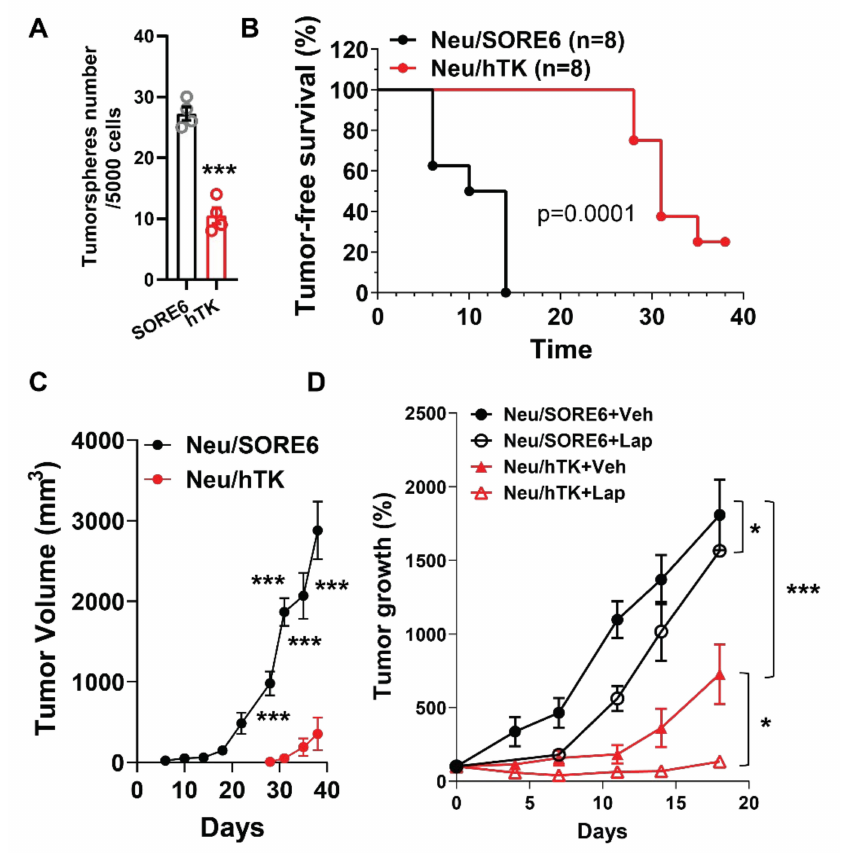
Figure 6. Ablation of SORE6 + CSCs suppresses Neu tumor initiation and progression and enhances the therapeutic efficacy of lapatinib. ( A ) GVC (10 µ M) treatment suppresses tumorsphere formation of Neu cells expressing SORE6-hTK (hTK) as compared to SORE6-mCherry (SORE6). *** p < 0.001 vs. SORE6, n = 4. ( B – D ) Neu cells expressing SORE6-mCherry (Neu/SORE6) or SORE6-hTK (Neu/hTK) were implanted into the mammary fat pad of nude mice and were either treated with GCV (25 mg/kg, i.p., daily) for 21 days immediately following implantation ( B , C ) or with GCV (25 mg/kg, i.p., daily) in combination with vehicle (Veh) or lapatinib (200 mg/kg, o.g., daily; Lap) for 21 days, when tumors reached the size of 150–200 mm 3 ( D ). Tumor growth was measured via caliper and expressed as percentage change in the tumor volume after drug treatment. ( C ) *** p < 0.001 vs. Neu/SORE6, n = 8. ( D ), * p < 0.05 Neu/SORE6 + Veh vs. Neu/SORE6 + Lap, or Neu/hTK + Veh vs. Neu/hTK + Lap; *** p < 0.001 Neu/hTK + Veh vs. Neu/SORE6 + Veh, n =